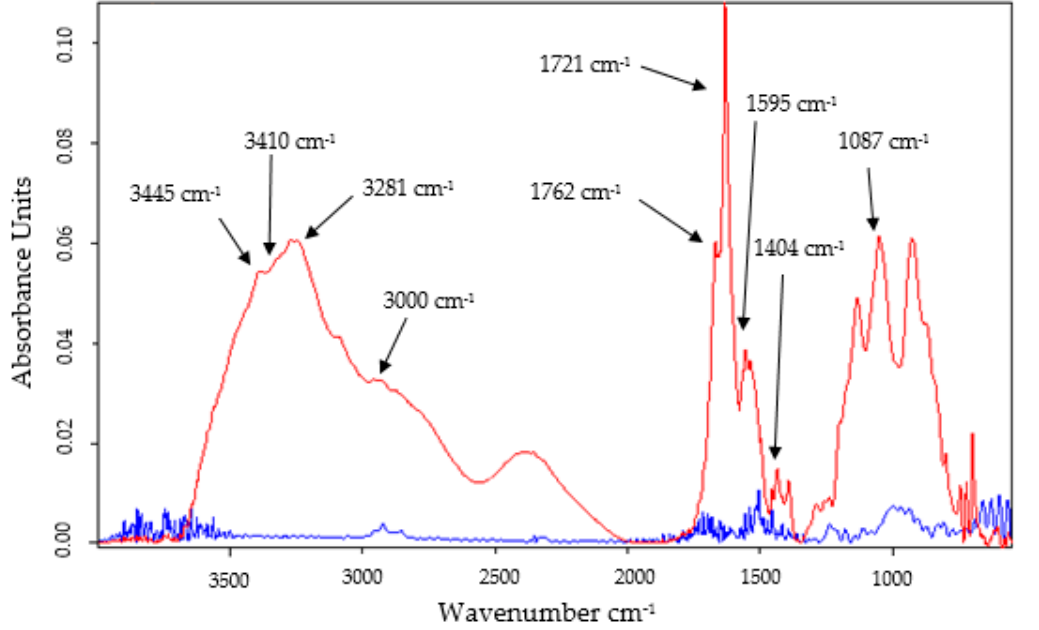
Figure 3. FTIR spectra for SPCE/GPHOX (blue line) and SPCE/GPHOX-Pentapeptide/(red line).